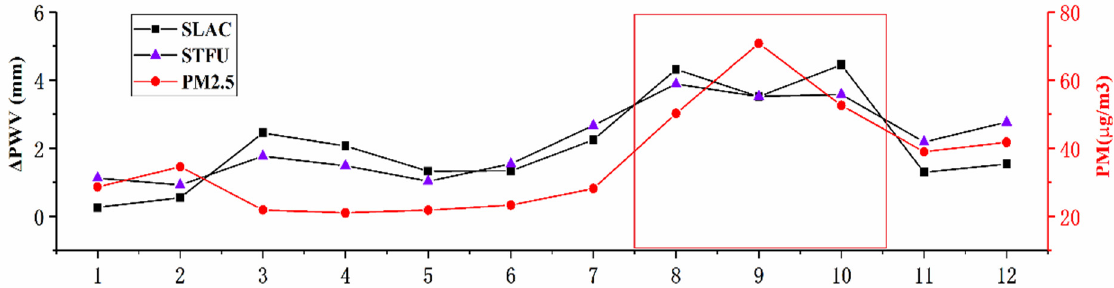
Figure 5. Comparison of monthly mean values of ∆ PWV and PM2.5 at SLAC and STFU stations (the fire period is in the box).